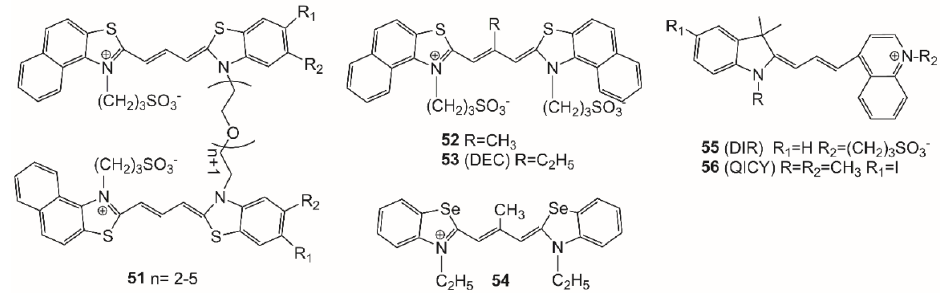
Figure 12. Structures of trimethine cyanines 51 – 56 .